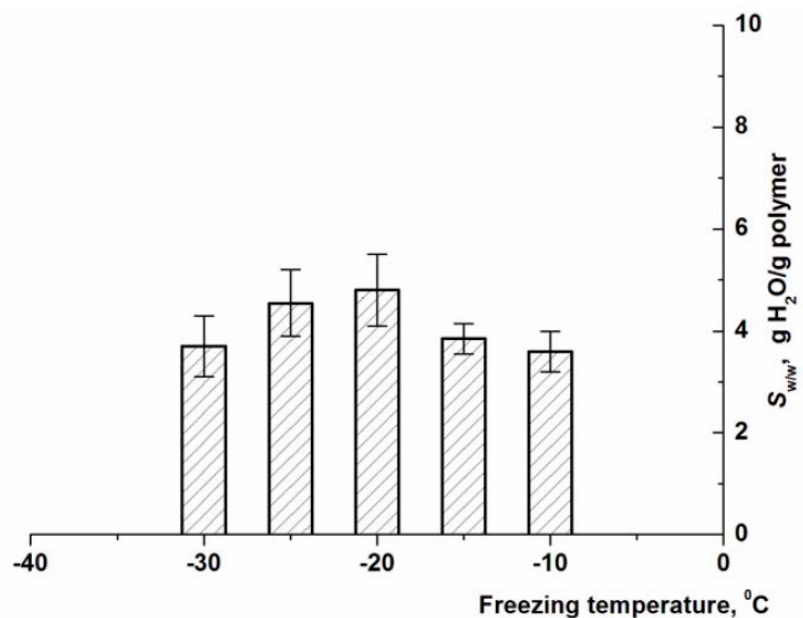
Figure 3. The swelling degree of the polymeric matter in the walls of macropores of Ca-ACRS samples formed by freezing the Na-ALG solution (30 g/L) at different negative